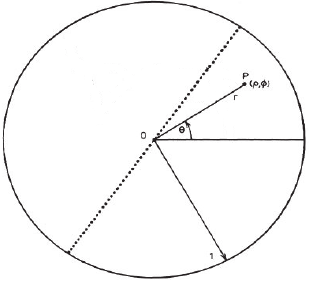
Fig. 2: Coordinate systems. Arbitrary point P has cylindrical polar coordinates (r, ϴ) with origin O and curvilinear polar coordinates with origin O; Φ is constant on the curved dashed lines and ρ is constant on the curved full line intersecting the dashed line as redrawn from [11].